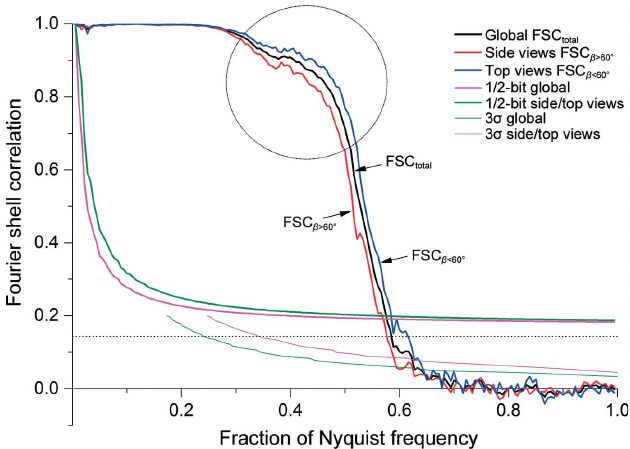
Figure 11 FSC curves of the final three-dimensional reconstruction. (0.6 of the Nyquist frequency corresponds to 1/3.7 A˚ .) FSC (cid:3) <60 (cid:5) is based on the preferred top-view class averages (0 < (cid:3) < 60 (cid:5) ); FSC (cid:3) >60 (cid:5) assesses the contributions of the side-view class averages (60 < (cid:3) < 90 (cid:5) ). The circle indicates the area in which a high FSC value is a good indicator of the quality of the